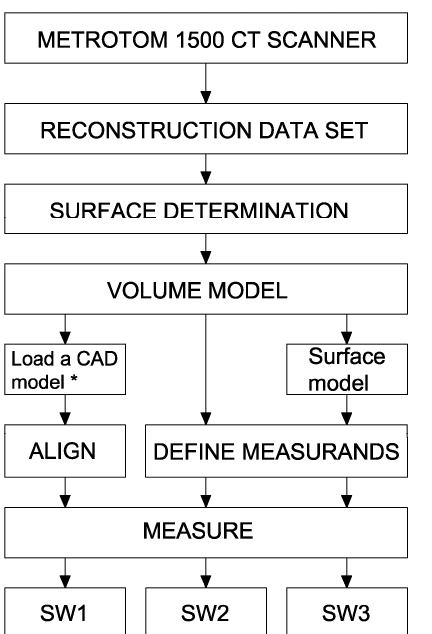
Fig. 2. Measuring procedure for selected software. *CAD model with already programmed measurement plan.